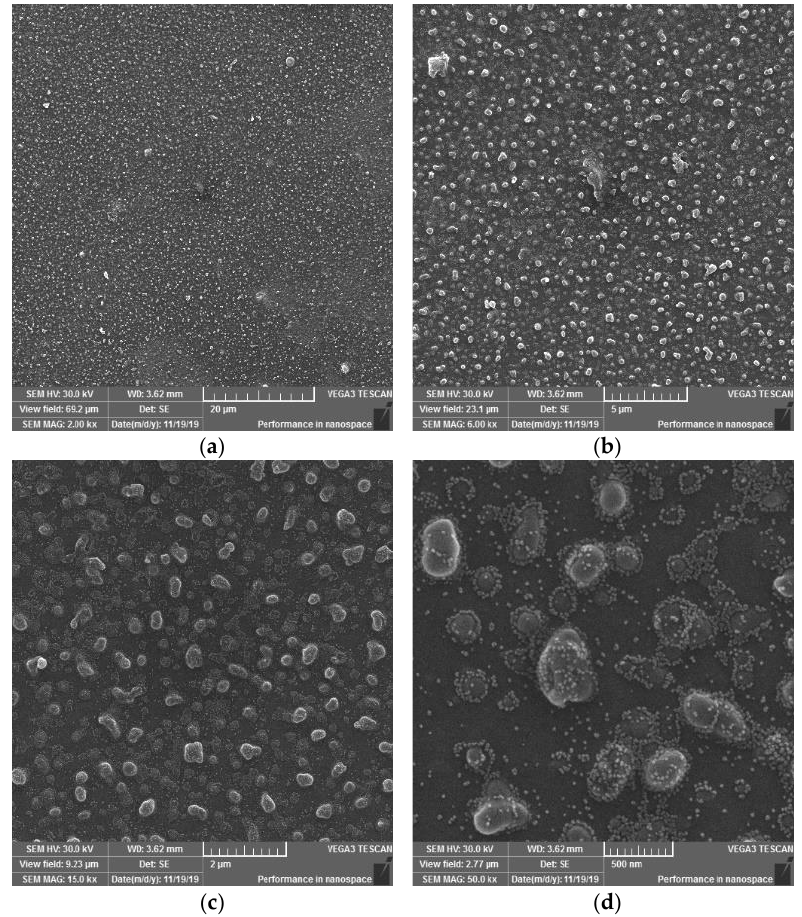
Figure 12. SEM morphology of the surface of plasma modified PVC exposure type I. Observed mag- nifications: 2000× ( a ), 6000× ( b ), 15,000× ( c ), 50,000× ( d ). magnifications: 2000 × ( a ), 6000 × ( b ), 15,000 × ( c ), 50,000 × ( d